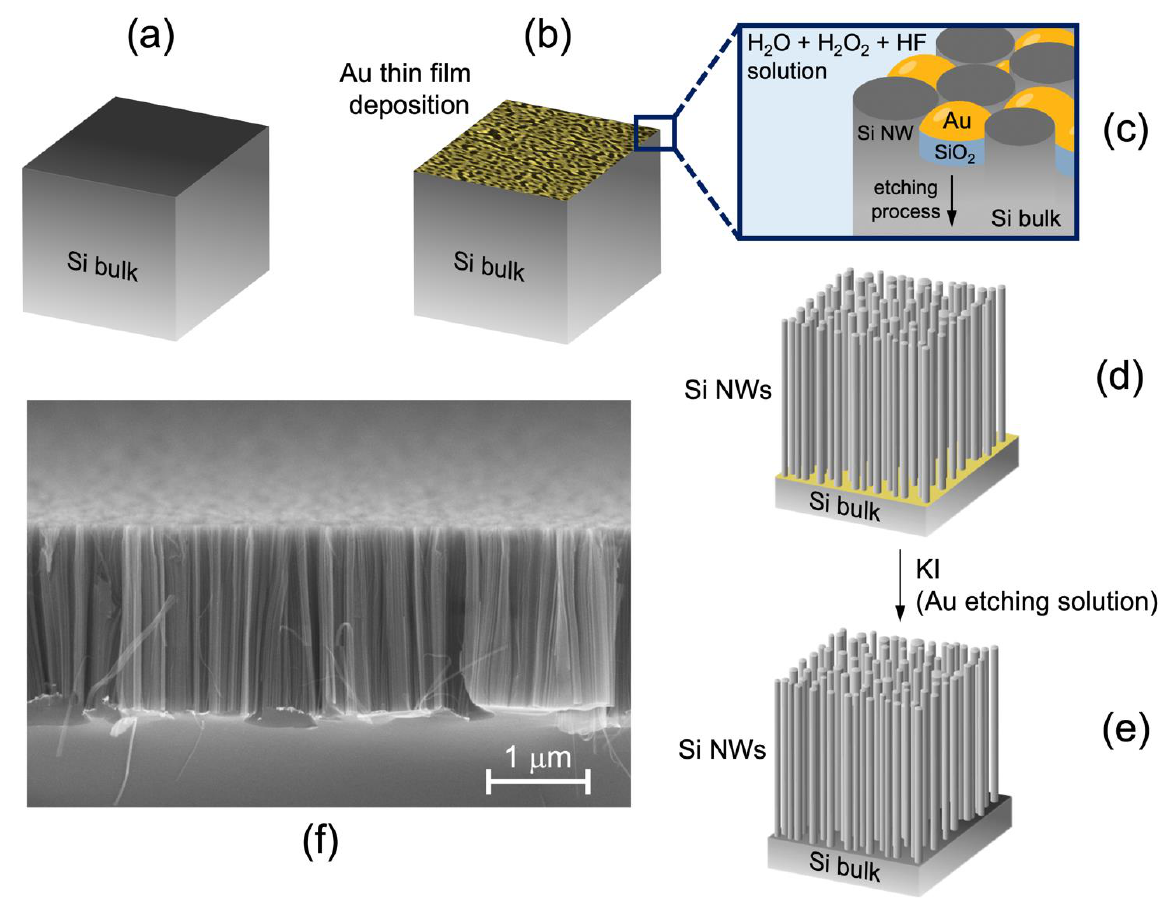
Figure 1. ( a – e ) Schematic representation of the Si NW realization process by using the MACE technique. ( f ) Scanning Electron Microscopy of Si NWs in cross section.